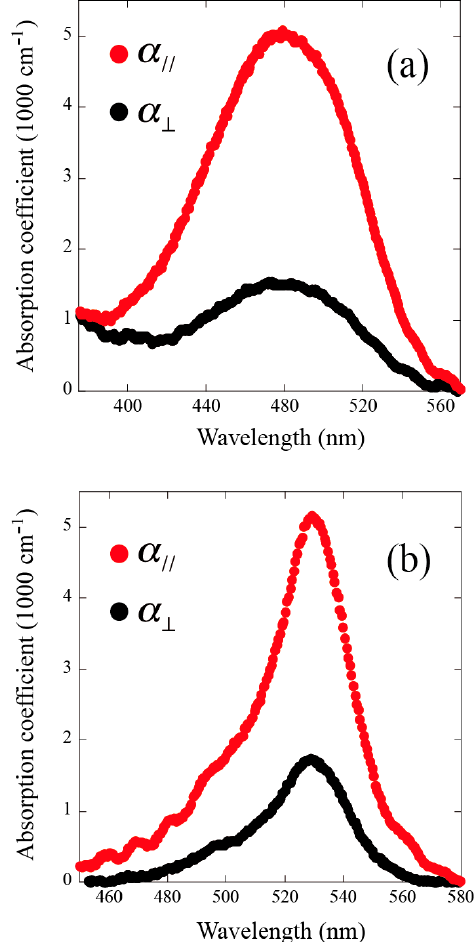
Figure A1. Spectra of the principal components of the absorption coefficient of an aligned nematic sample of E7 doped with DCM (1 wt %) ( a ); and with PM597 (1 wt %) ( b ).